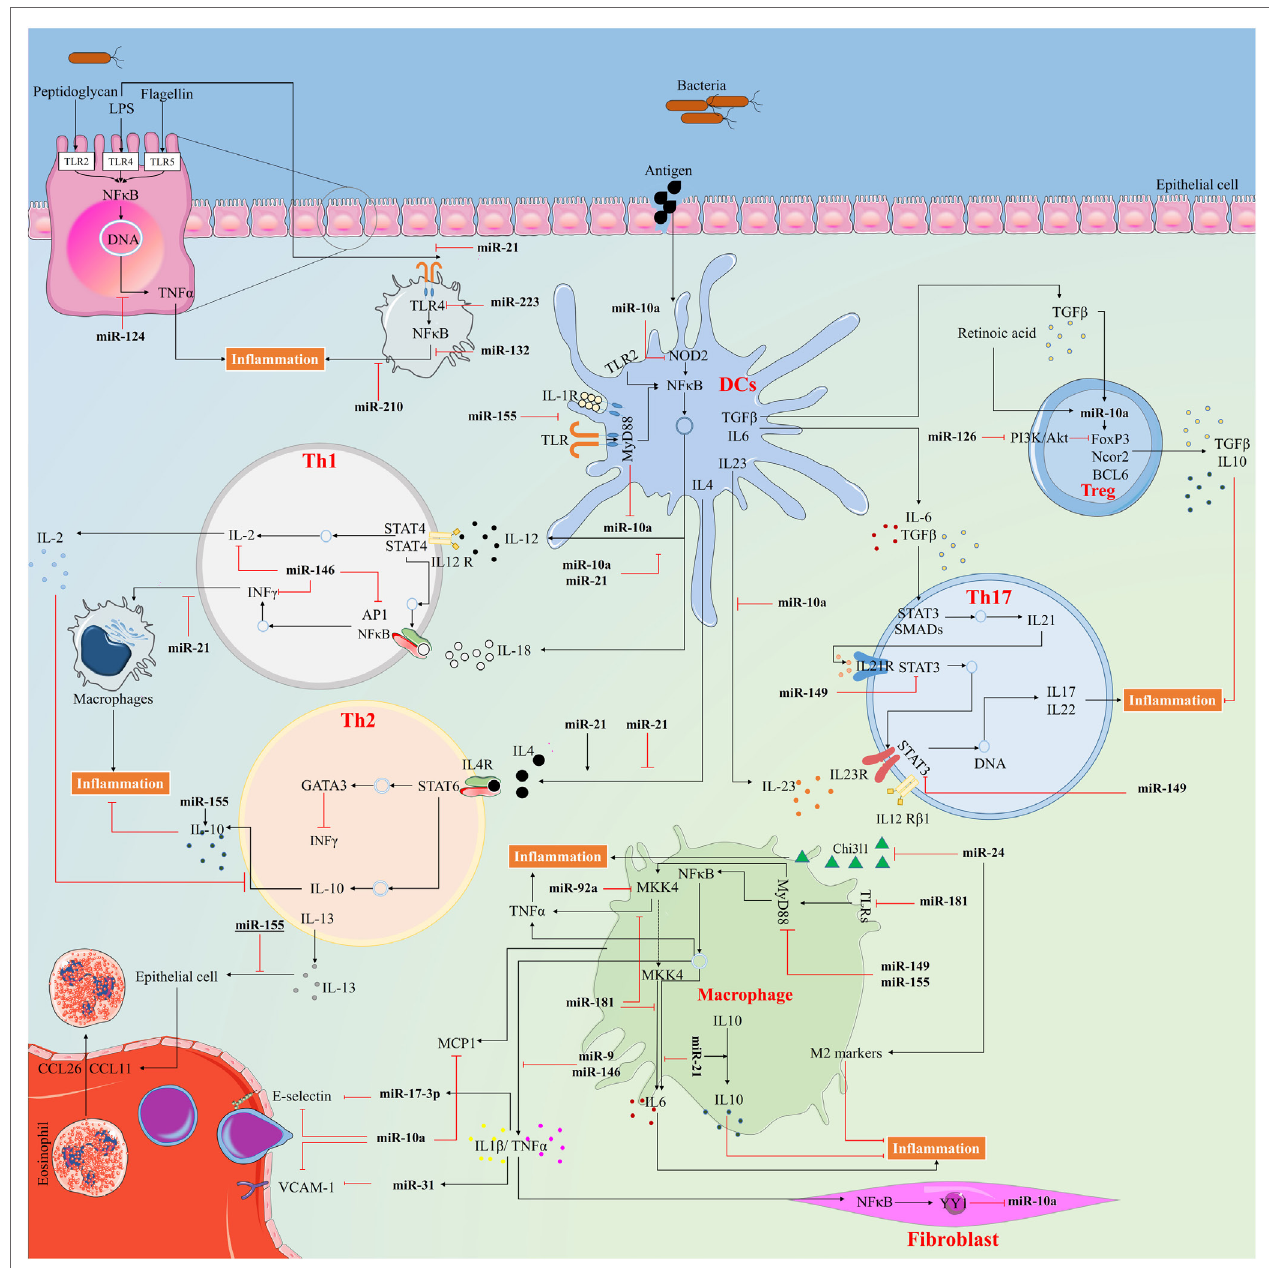
FigURe 4 | The way anti-inflammatory microRNAs (miRNAs) exert their action to control inflammatory response. miRNAs serve in important negative feedback loops in inflammation processes and inflammatory diseases. By targeting signal transduction proteins involved in the initiation of innate immune response, and by directly targeting mRNAs that encode specific inflammatory mediators, miRNAs can have an important impact on the magnitude of the ensuing inflammatory